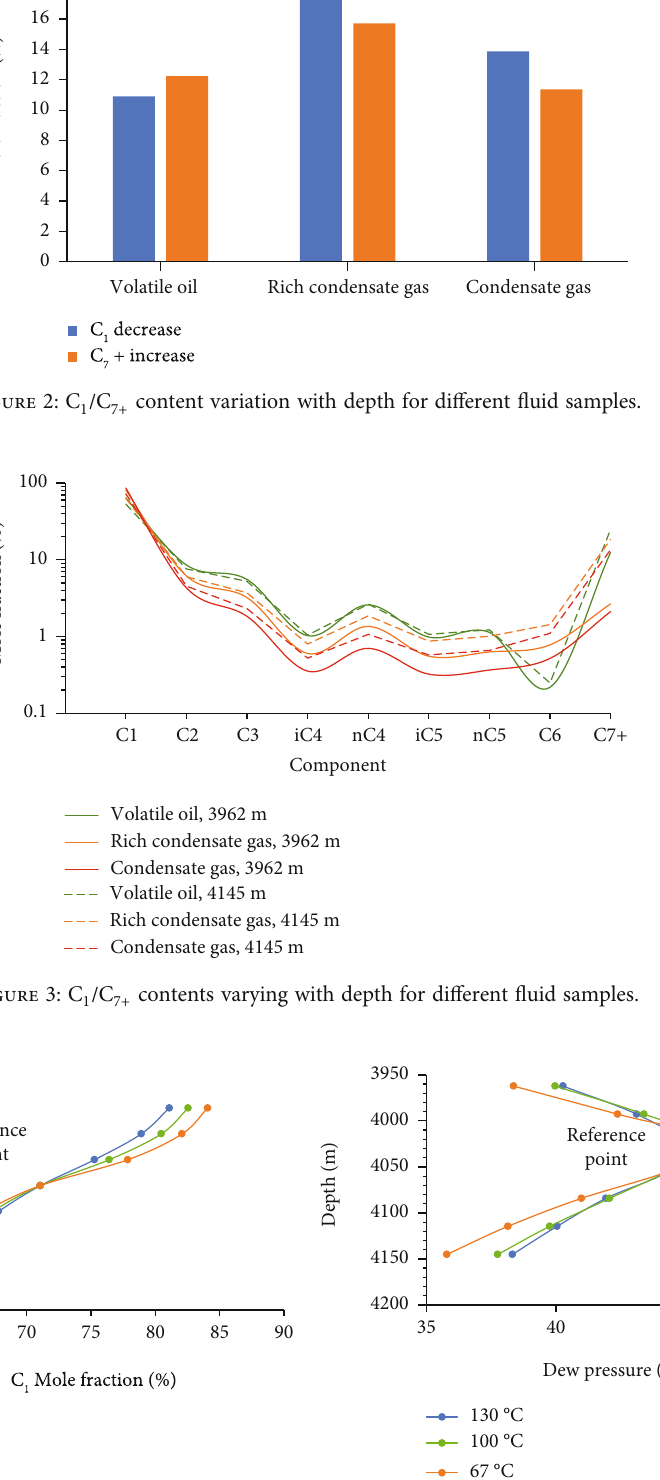
Figure 4: (a) E ff ect of reservoir temperature on compositional gradient. (b) E ff ect of reservoir temperature on dew point